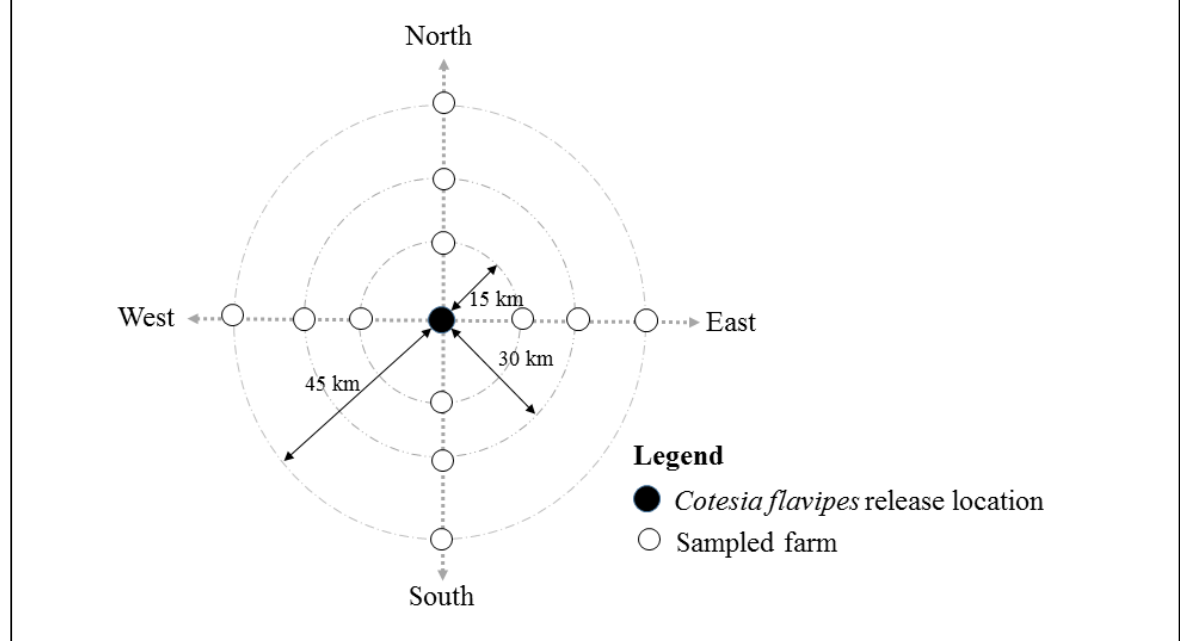
Figure 2: Cotesia flavipes release point and sampling transect radiating in four main compass point directions at 15, 30 and 45 km